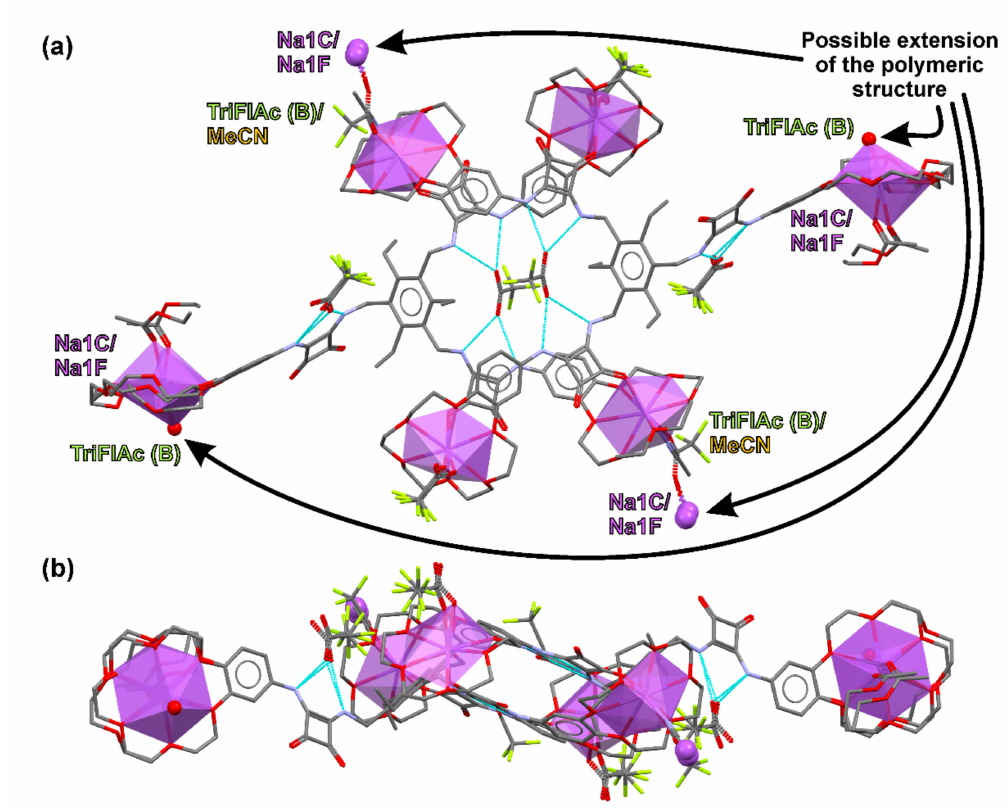
Figure 5. Centrosymmetric dimer in the structure of 1 + Na_triFlAc , view from the top ( a ) and rotated view along longer axis of the dimer ( b ). Violet polyhedra represent the coordination of Na + cations by crown ether rings. Hydrogen bonds marked as cyan dashed lines. Unbound solvent molecules and H atoms omitted for